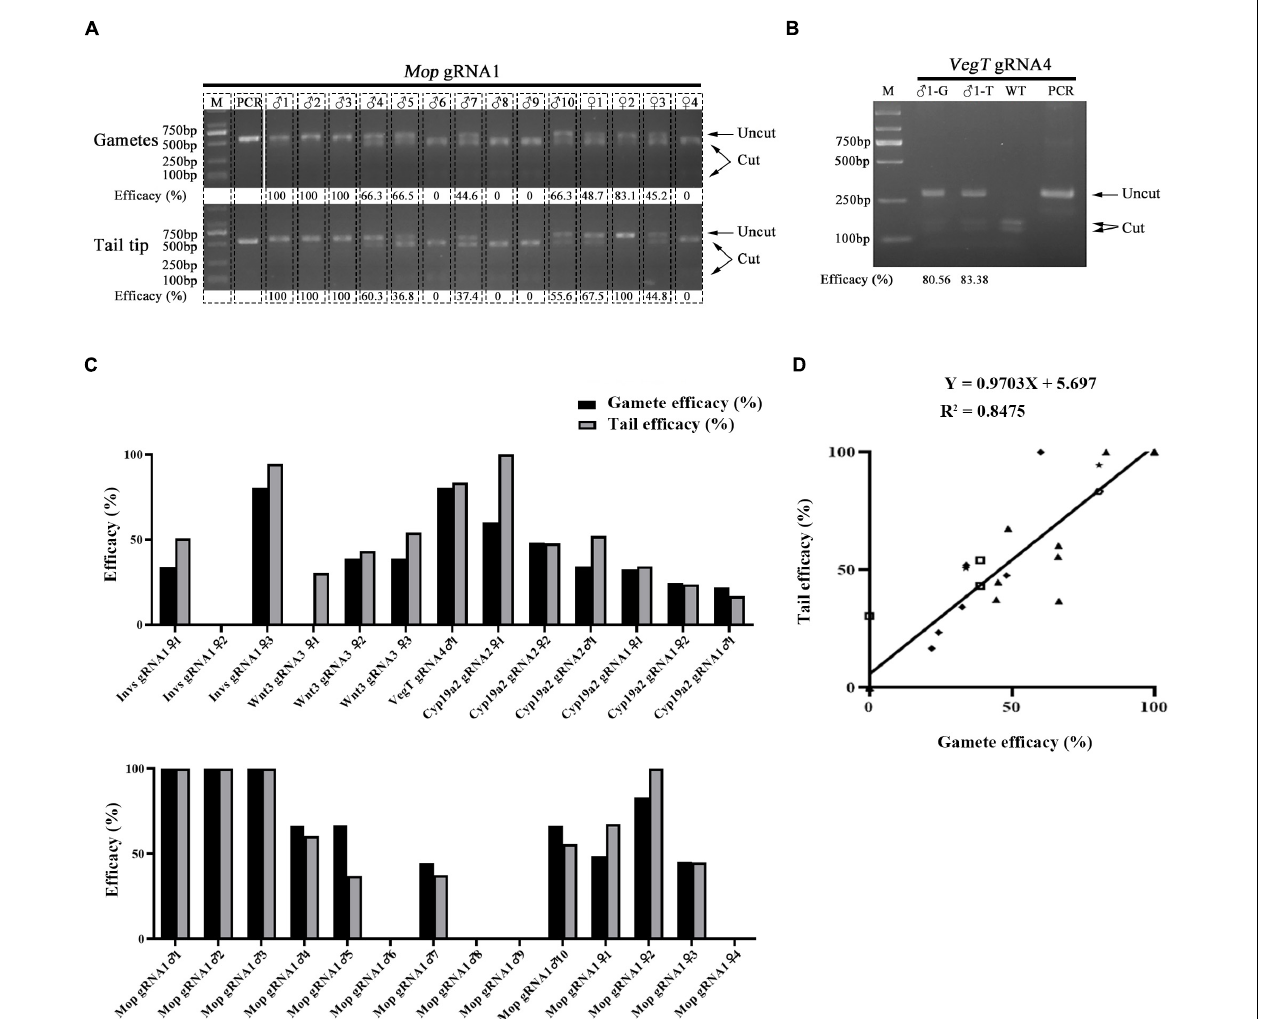
FIGURE 1 | Correlation of mutation efficacy between tail tips and gametes of F0 individuals. (A,B) Mutation detection in tail tips (T) and gametes (G) of F0 individuals injected with Mop gRNA1 (A) and VegT gRNA4 (B) . The induced mutation efficacies (estimated as percentages of uncut PCR products) are labeled under the gel image. (C) Summary of mutation efficacies detected in tail tips and gametes of all F0 individuals examined. (D) Correlation analysis of efficacies between tail tips and gametes of F0 individuals. Efficacy of each gRNA is marked with a different symbol. The linear equation is Y = 0.9703X + 5.697, R 2 = 0.8475.